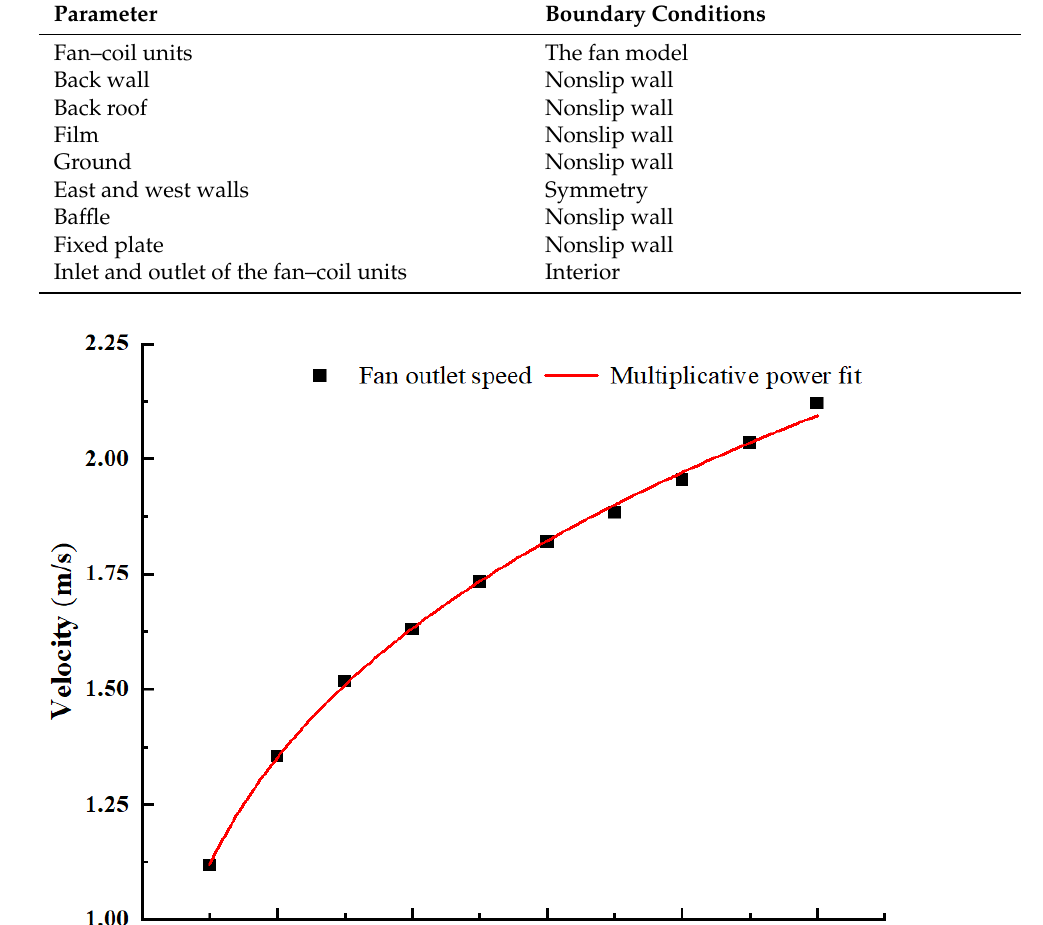
Table 1. Boundary conditions for the simulation model.